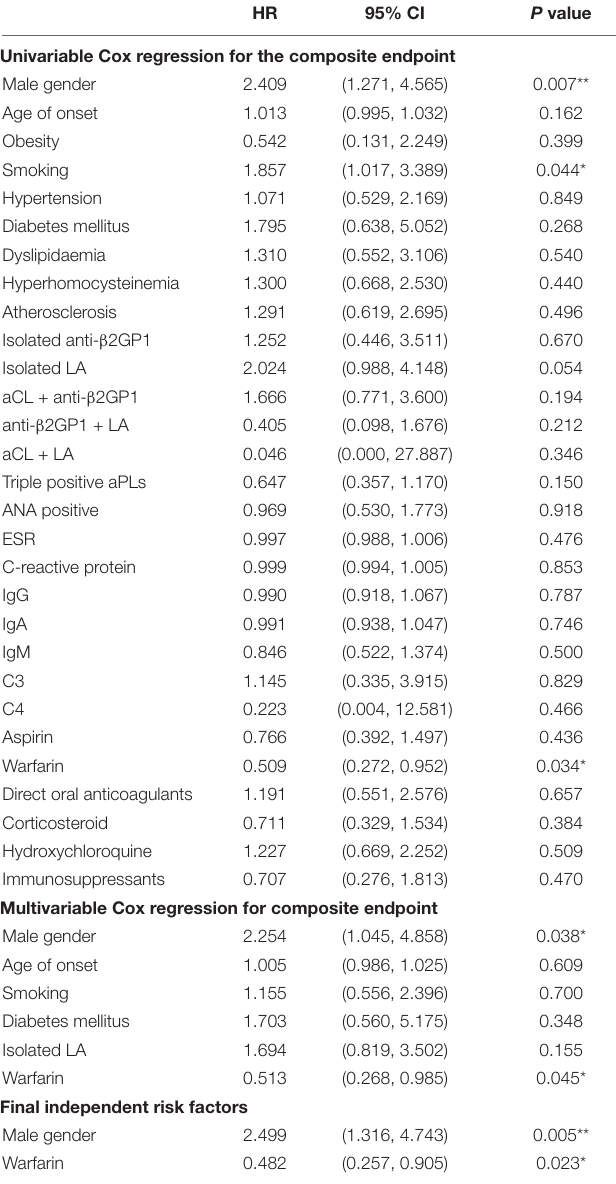
TABLE 3 | Univariable and multivariable Cox regression for a composite endpoint in patients with primary thrombotic antiphospholipid syndrome (ptAPS). HR 95% CI P value